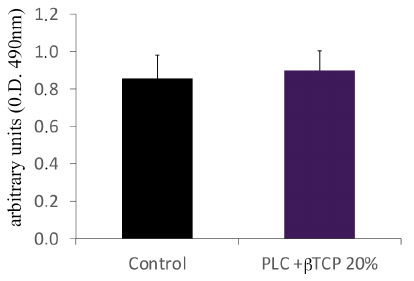
Figure 7. MTS assay. Note the suitability of the poly(ε-caprolactone) (PCL) compounded with be- ta-tricalcium phosphate 20% (PCL+β-TCP 20%) samples for supporting the growth and viability of the preosteoblasts relative to those cultured in the normal culture dishes. The values from three different experiments were calculated as the means ± the standard deviations. No statistically sig- nificant differences were observed ( p > 0.05).